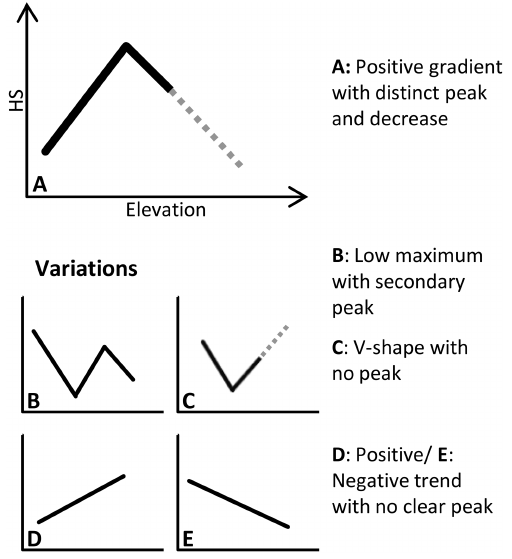
Figure 4. Idealised shape of elevation gradients and variations as identified from the data sets.